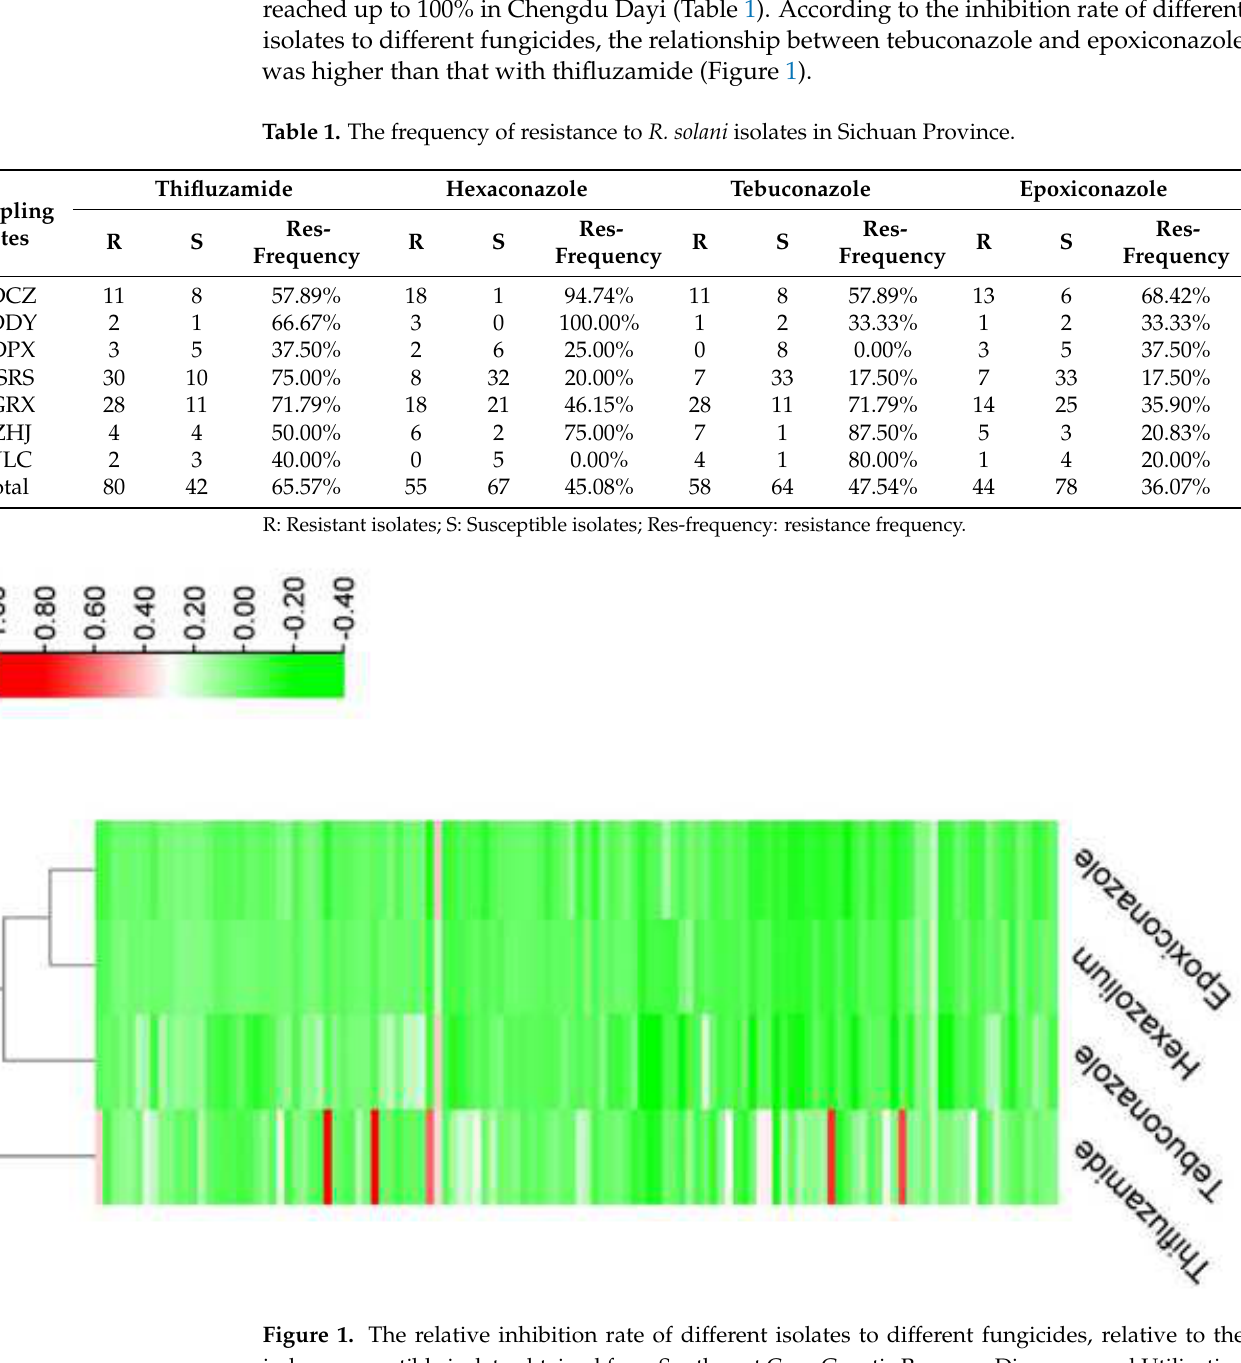
Figure 1. The relative inhibition rate of different isolates to different fungicides, relative to the indoor susceptible isolate obtained from Southwest Crop Genetic Resource Discovery and Utilization Laboratory of Sichuan Agricultural